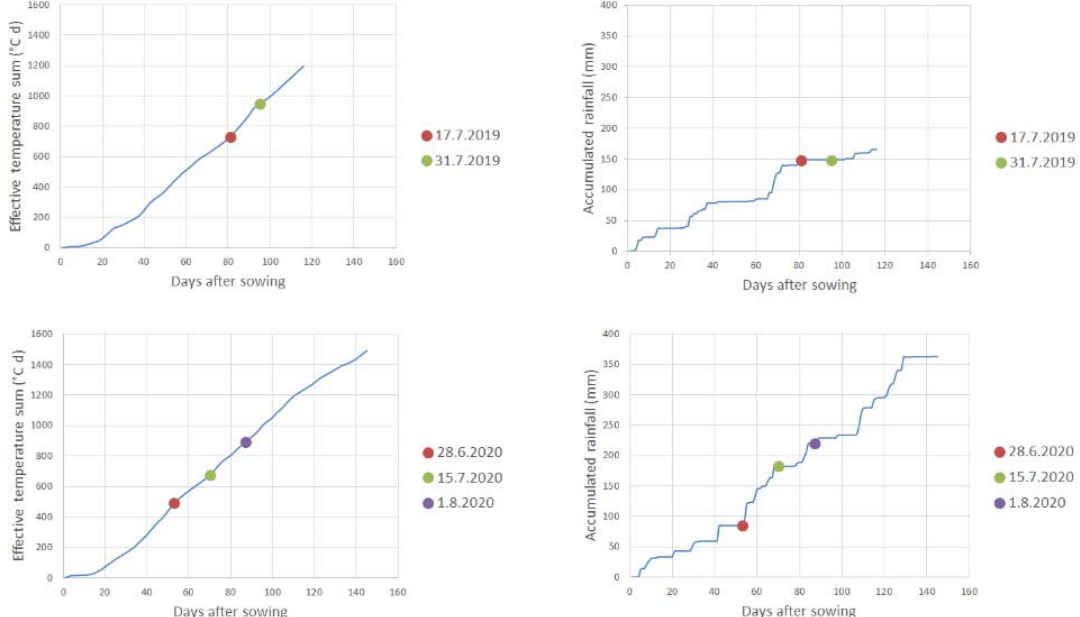
Figure 4. Accumulated rainfall (mm) and effective temperature sum (°C d) for both measurement years. The effective temperature sum was calculated by measuring the average temperature of each day, subtracting 5 °C from it, and summing the positive differences with each other. The flight days are marked as dots.